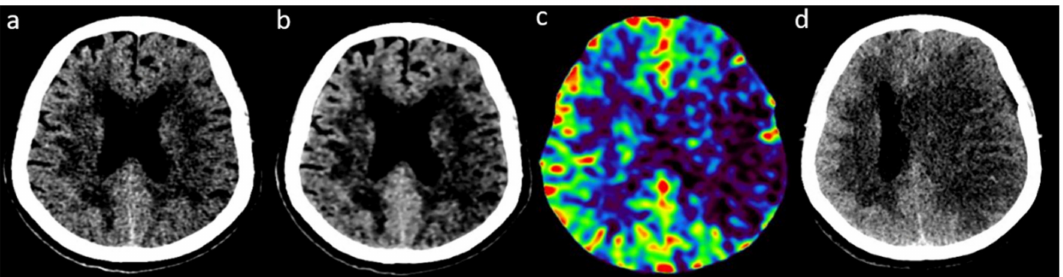
Figure 4. Illustrative case of an acute ischemic stroke with clot in left M1. ( a ): NCCT with AIDR3D; ( b ): NCCT with FIRST-LCD with the same windowing); ( c ): rCBV-map; ( d ): NCCT follow-up imaging (24 h). ( a , b ) Hypodensity in left middle cerebral artery territory. ( c ) Hypoperfusion in the same territory and ( d ) Ischemic infarction with mass effect.